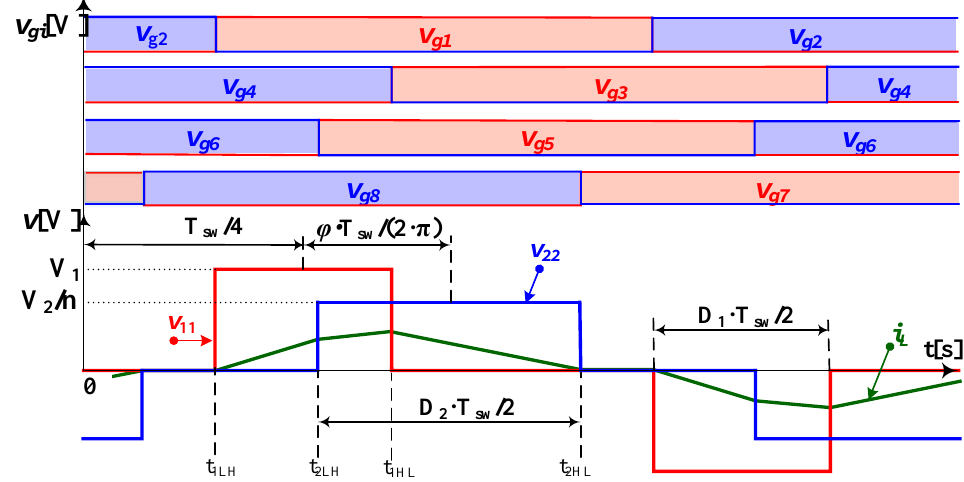
Figure 3. Typical voltages and current for a Dual active bridge (DAB) with a Triple phase shift (TPS) modulation.